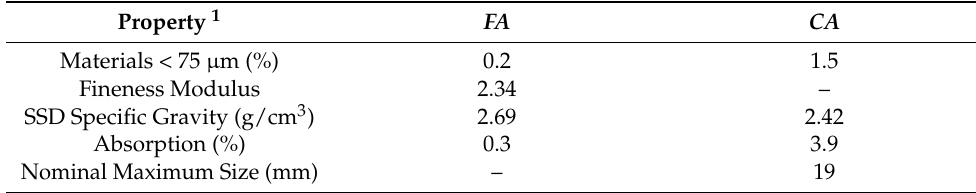
Table 1. Physical properties of aggregates.